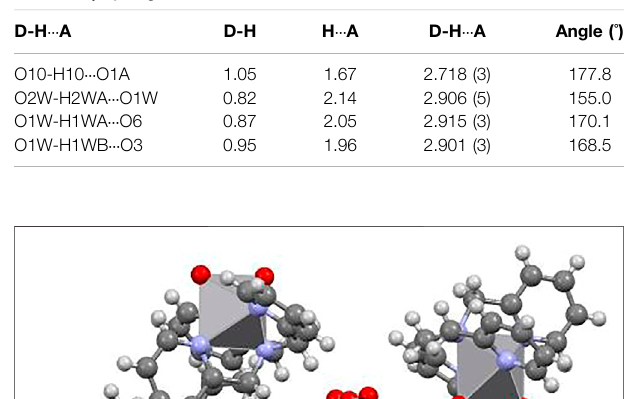
TABLE 2 | Hydrogen bonds.